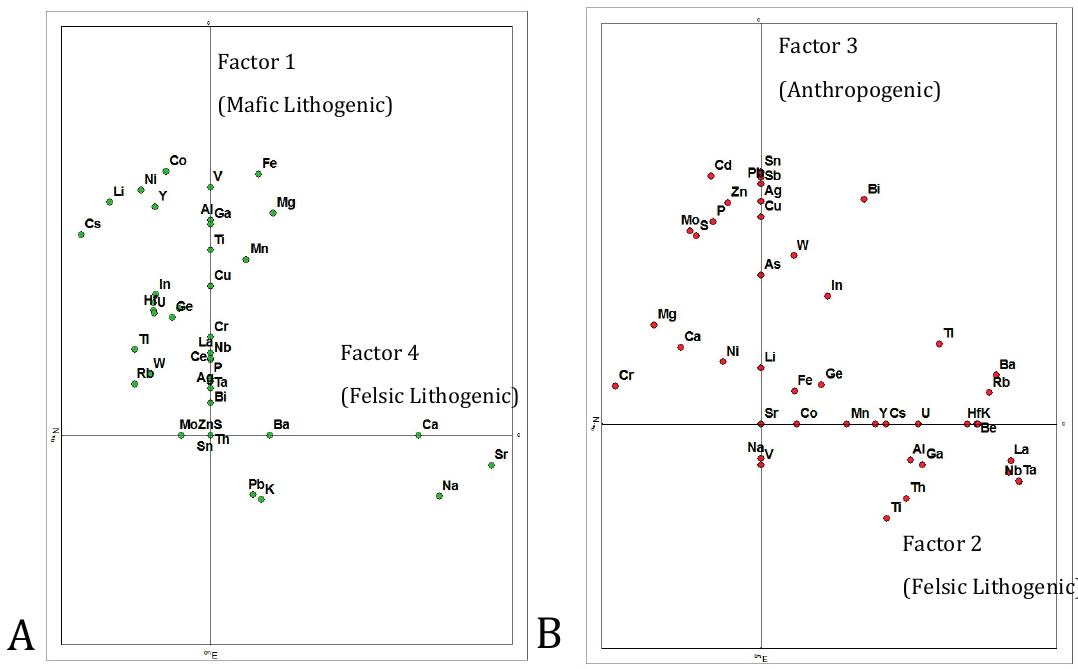
Figure 4. Factor analysis of Sacramento soil geochemical data, suggesting lithogenic and anthropogenic geochemical